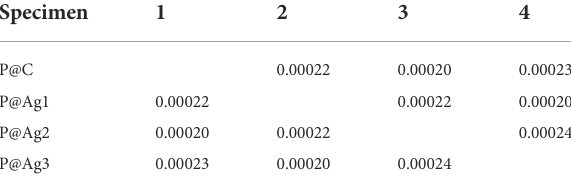
TABLE 3 Newman-Keul test for XRF test values in terms of AgNO3 loading for P@Ag1, P@Ag2, and P@Ag3 samples.